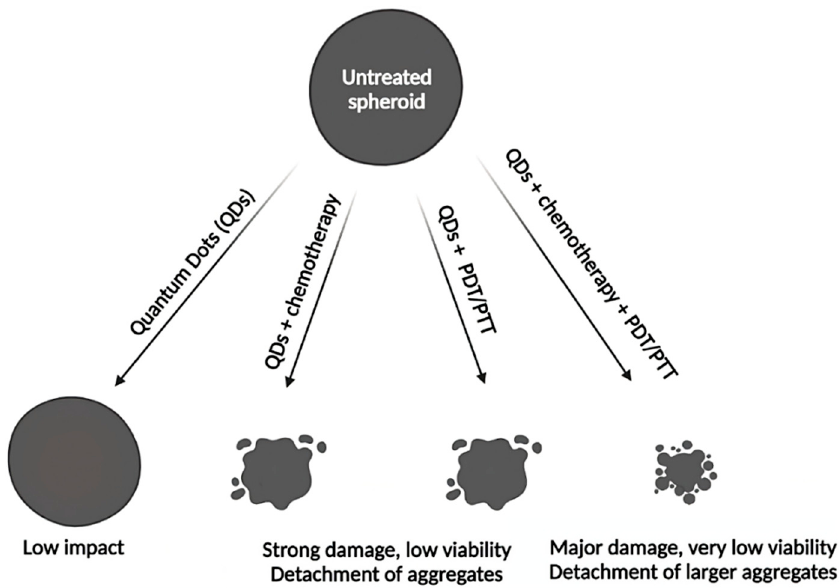
Figure 5. Simplistic representation of different treatment modalities induced by QDs aiming to destroy spheroids. QDs themselves have a low antitumor activity on spheroids. QDs combined with chemotherapy or used alone for PDT/PTT induced a significant decrease of spheroid size and viability, although not fully destructed them. This effect is further increased with combination of PDT/PTT with chemotherapy, demonstrating the highest cytotoxic effect. Please refer to experimental details [89–92] in the Table 2 of the main text.